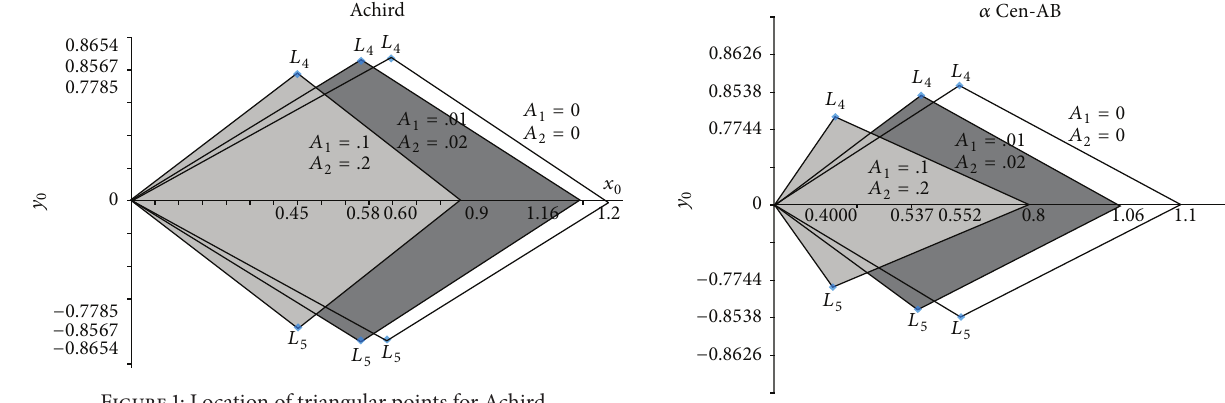
Figure 3: Location of triangular points for 𝛼 Cen-AB.